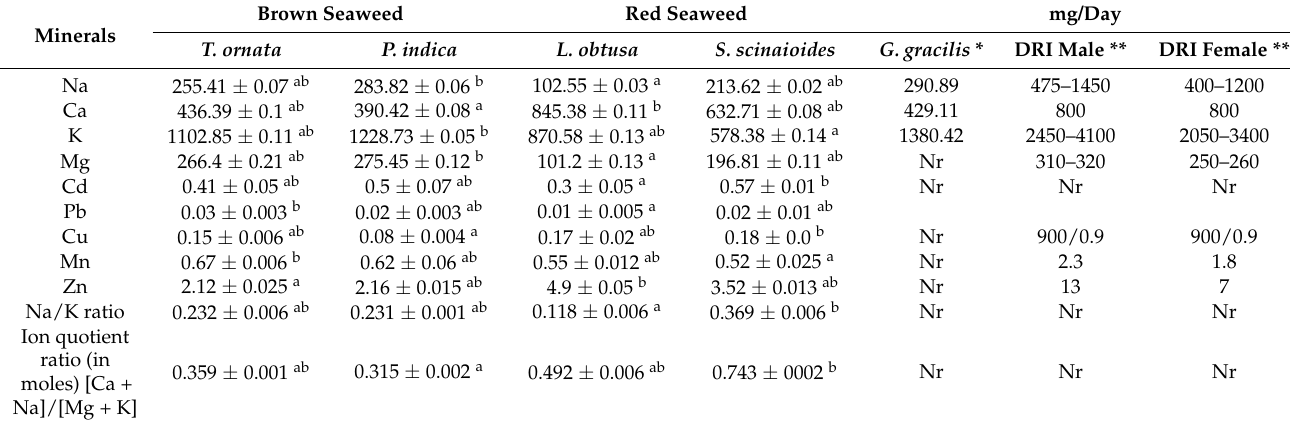
* Rasyid et al. [59]. ** Dietary reference intake: the amount recommended for consumption daily for Thai adults of age 19–50 years [56]. Nr: not reported due to lack of suitable data. Values are means of three replicates ± standard deviations (SD). Different letters refer to significant differences between species ( p <